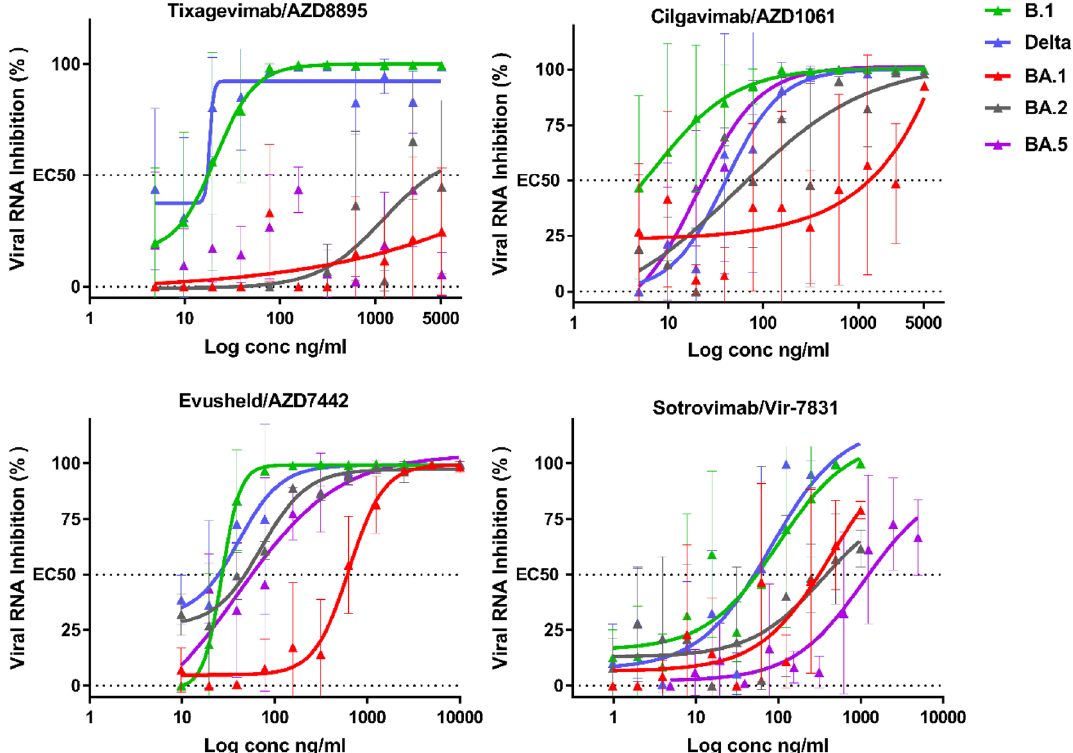
Figure 2. Dose response curves reporting the susceptibility of the SARS-CoV-2 BavPat1 D614G (B.1) ancestral strain,Delta BA.1 BA.2 and BA.5 variant to active therapeutic monoclonal antibodies Sotrovimab/ Vir-7831,Tixagevimab/AZD8895, Cilgavimab/AZD1061 and Evusheld/AZD7742. Data presented are from one representative experiment. Data presented are from three technical replicates in VeroE6-TMPRSS2 cells, and error bars show mean ± s.d.